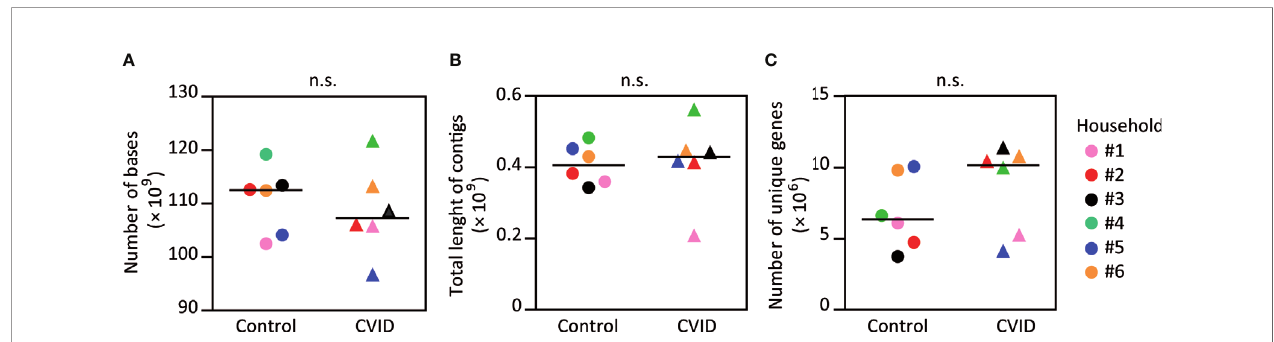
FIGURE 1 | The fecal microbiomes of CVID patients and healthy controls have similar numbers of determined bases, contig lengths, and numbers of unique genes. The obtained metagenome data showed no difference in number of determined nucleotides (A) and the length of contigs (B) between the CVID patients and healthy controls. The numbers of unique genes were also similar (C) . Please, notice an insigni fi cant increase of unique genes for CVID. Mann-Whitney test; n.s., not signi fi cant. Symbols, individuals. Black bar, median. Detailed characteristics of samples are shown in Table S2